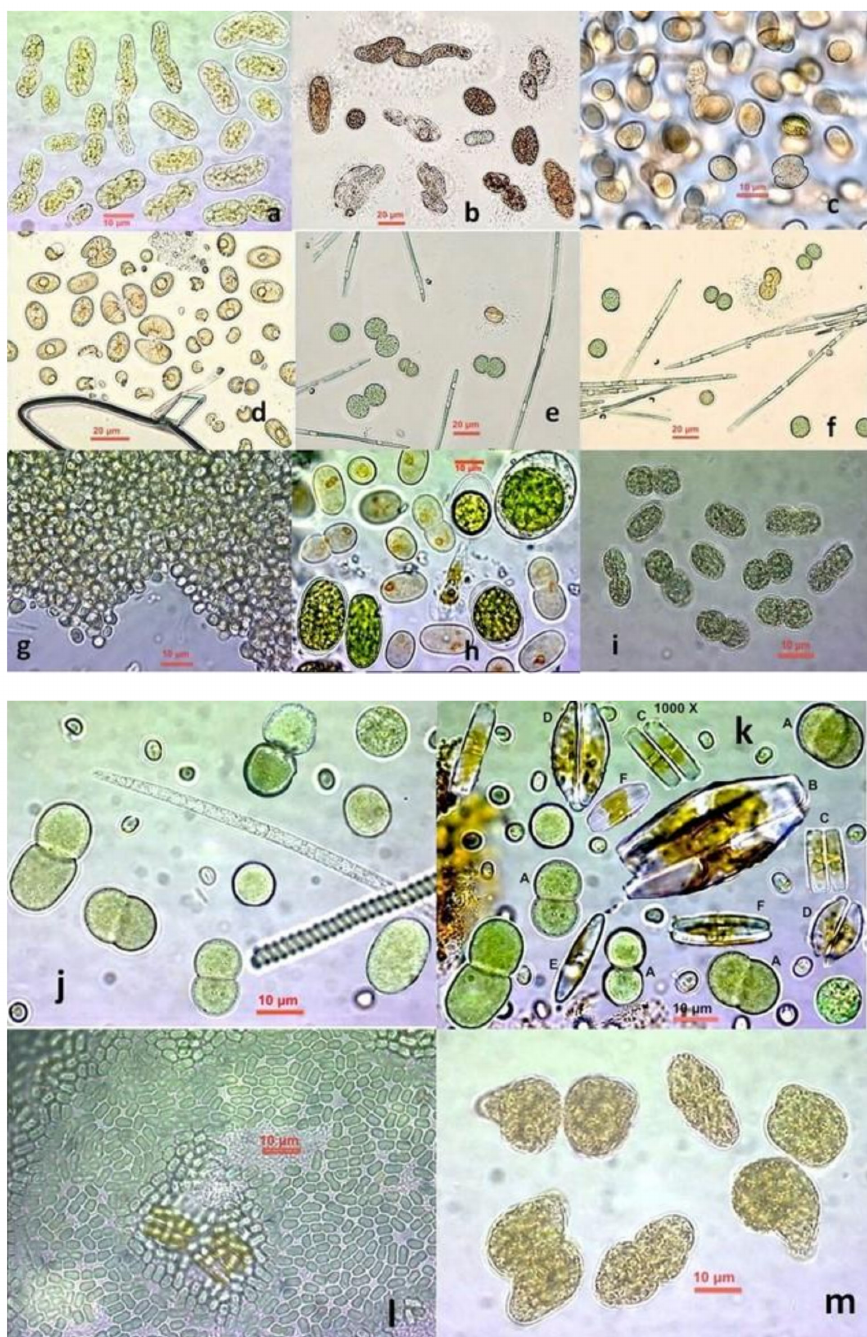
Figure 1. Cocciform Cyanobacteria from hypersalinity at Messolonghi saltworks. ( a ) Peculiar involuted cells of an unidentified species; ( b ) variously shaped cells, sole, involuted and dividing, probably of genus Synechococcus and in some of them with a mucilage layer around cells; ( c ) totally unknown species; ( d ) kidney-shaped cells of an unknown species; ( e , f ) various cells of genus Cyanothece in division state; ( g ) Microcystis sp. colony; ( h ) Synechococcus -like cells among normal and palmelloid cells of the chlorophyte Tetraselmis marina ; ( i ) probably Synechococcus sp.; ( j ) Cyanothece sp. cells at various stages of division along with an Arthrospira sp. filament; ( k ) Aphanothece sp. and Cyanothece sp. cells along with pennate diatoms; ( l ) dense colony of small greenish cells of the Synechococcus type; ( m ) peculiar involuted cells of probably Synechococcus